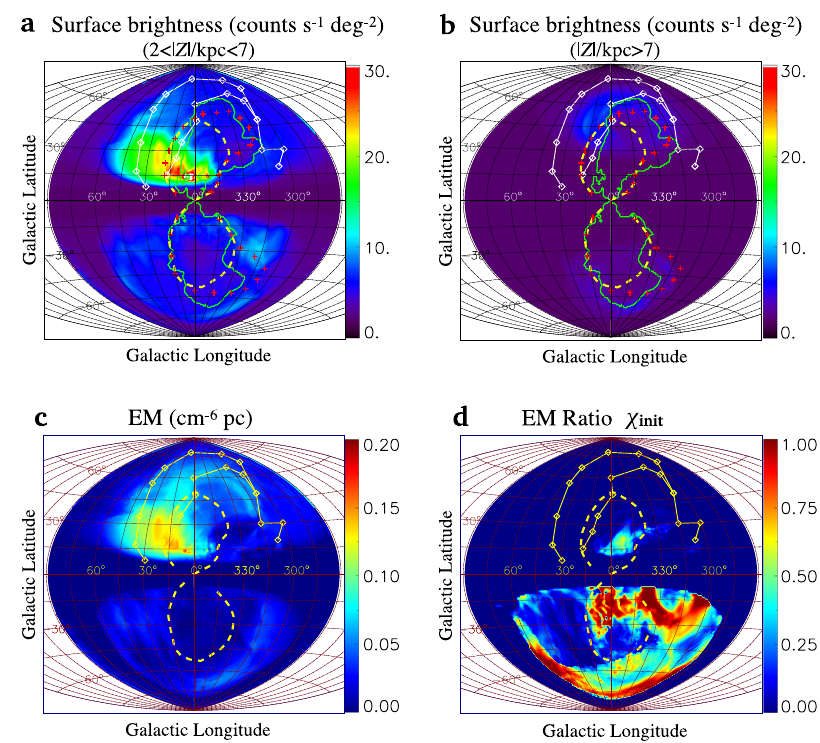
Fig. 5 | Projections related to the X-ray. Panels a and b show segmented X-ray projectionsof2< ∣ Z ∣ /kpc<7and ∣ Z ∣ /kpc>7,respectively.Thegreenlinesrepresent the outlines of bubble cavities fi lled by nuclear out fl ow ( T >6×10 6 K) which may account for the PRLs 15 (red crosses). The morphology of PRLs de fi nitely bends